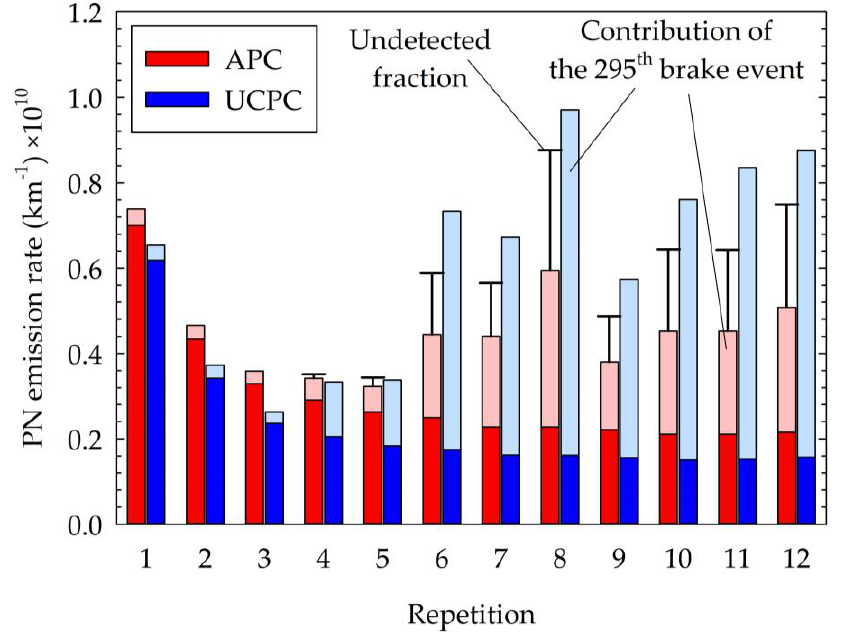
Figure 5. Evolution of Particle Number (PN) emissions over consecutive WLTP cycles starting from fresh pads (degreening). The combined red/light red bars correspond to APC (thermally treated samples), while the combined blue/light blue bars to ultrafine Condensation Particle Counter (UCPC) (untreated samples). The top (light blue–light red) section of the bars indicate the contribution of particles emitted during the braking event following high-speed cruising at the top cycle speed of 132.5 km/h (295th brake event) to the total particles emitted over the whole cycle. The error bars on the APC results correspond to the undetected fraction due to losses inside the instrument and the larger detection limit of the internal UCPC, calculated from the measured Engine Exhaust Particle Sizer (EEPS) size distributions (Figure 4).